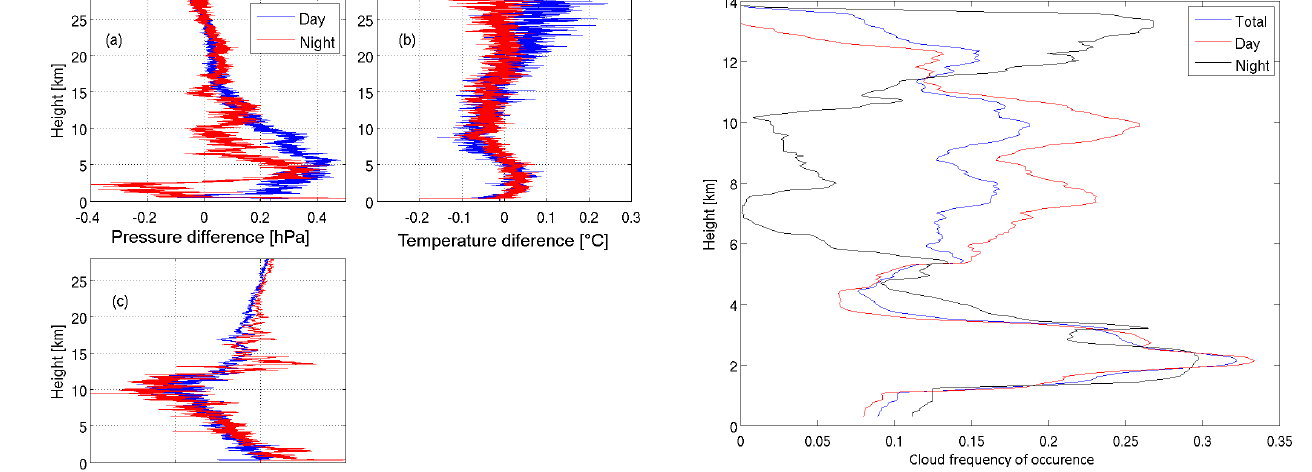
Figure 12. Comparison of cloud frequency of occurrence for day- time, nighttime, and all sounding launch times. Cloud frequency of occurrence is calculated using the ARSCL product and compiled over a 1h window following each sonde launch